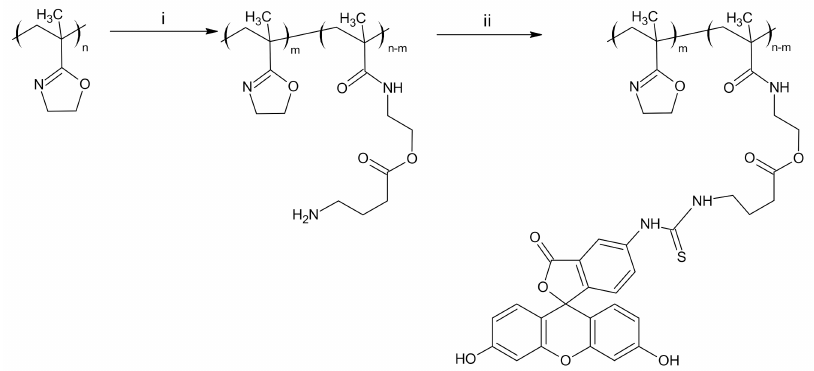
Figure 1. Two-step synthesis of PIPOx labeled with fluorescein (PIPOx-FITC) comprising of the introduction of amino moiety and reaction with fluorescein isothiocyanate (FITC). (i) ABA, DMAc,